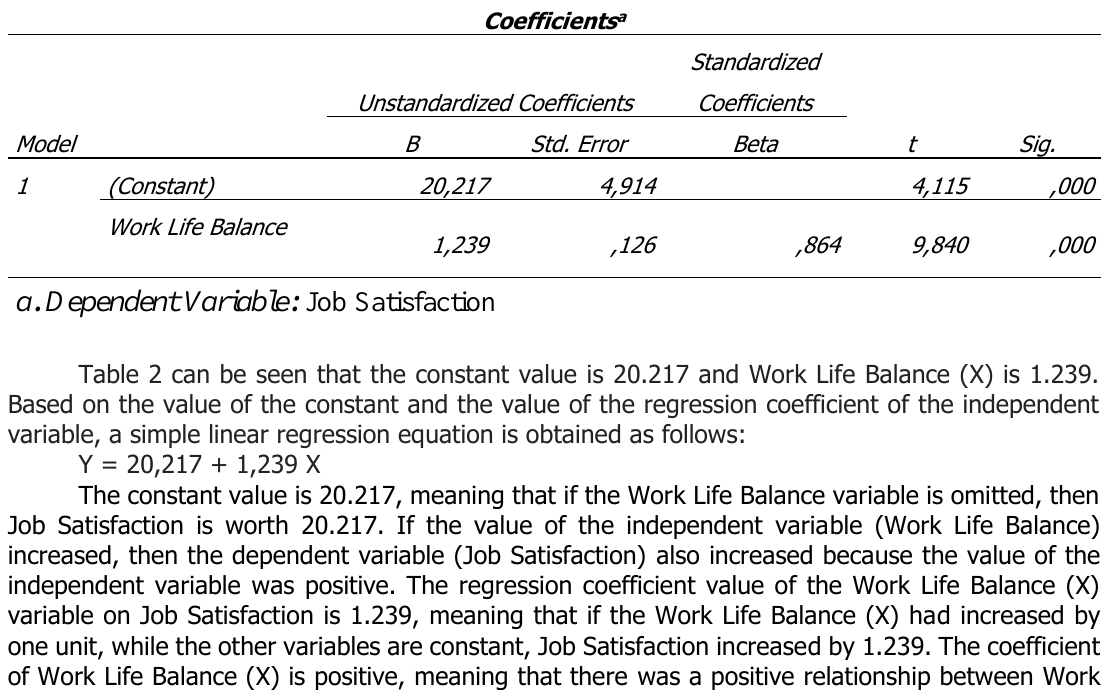
Tabel 2. Simple Linear Regression Analysis Result